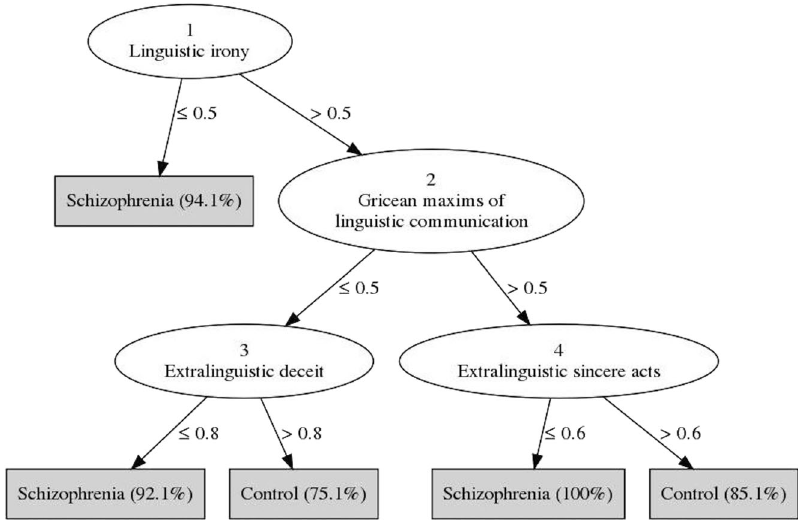
Fig. 1 DT model. A decision tree is used to classify an example by starting at the root of the tree (testing the value of Linguistic irony) and moving through it (testing the other features) until a leaf node (gray squares), which provides the classi fi cation of the instance (schizophrenia or healthy